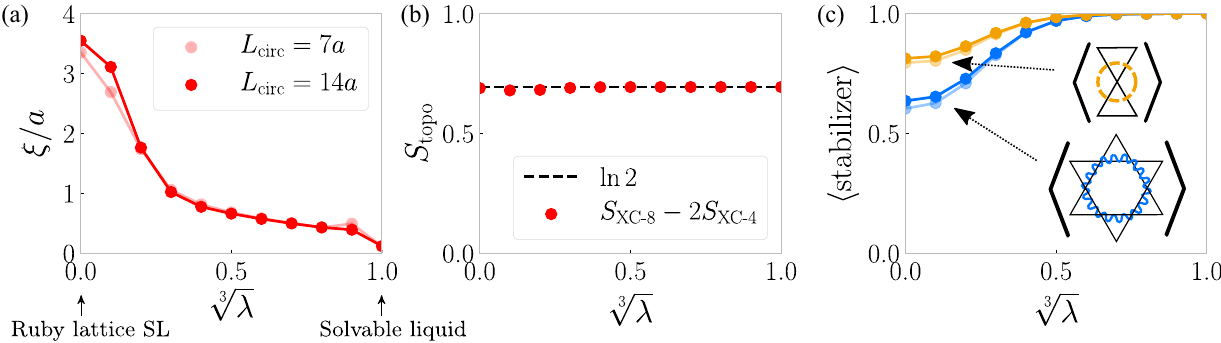
FIG. 7. Interpolating from the spin- 1 = 2 ruby lattice Ising model to the solvable dimer liquid. Equation (40) interpolates from an emergent dimer model at λ ¼ 0 [Eq. (15) with Eq. (20), which encodes the ruby lattice model [34]; see Sec. VI A] to the stabilizer Hamiltonian (24) for a dimer liquid at λ ¼ 1 (see Sec. III A). (a) Ground-state correlation length (in units of the lattice spacing of the ruby lattice) using iDMRG, which decreases as we tune toward the solvable point. In particular, we see no sign of a transition, confirming that the ruby lattice Ising model is indeed a spin liquid. The fainter data are for XC-4, which has L =a ≈ 14 . (b) Topological entanglement entropy, which is roughly constant throughout, close to the solid data are for XC-8 with L circ expected value of ln 2 . (c) Fixed-point dimer liquid defined by both types of stabilizers [ − G We track their expectation value along the interpolation, with the fainter (solid) data being for XC-4 (XC-8)